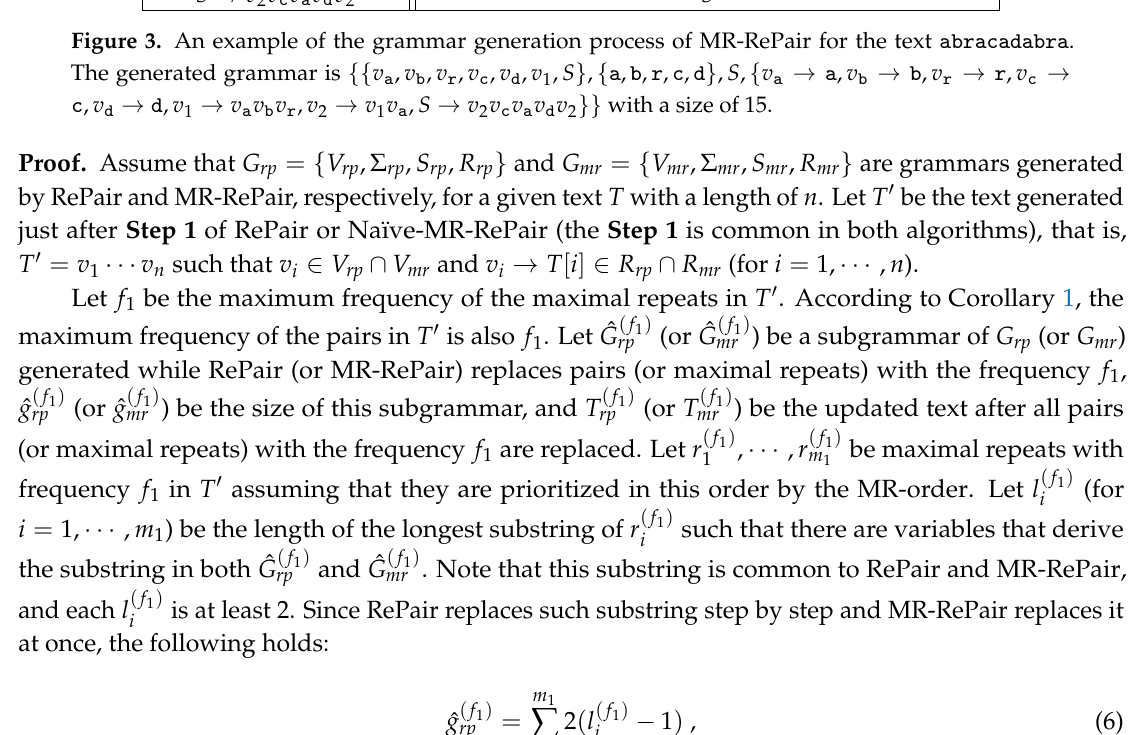
v a , v b , v r , v c , v d , v 1 , S {{